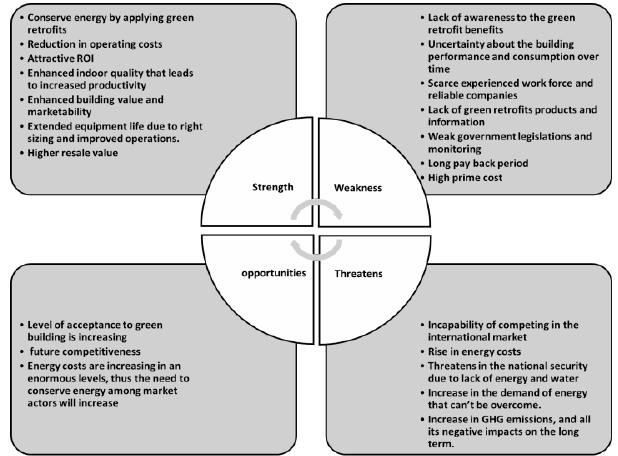
Figure 8. SWOT analysis to the Egyptian green market base